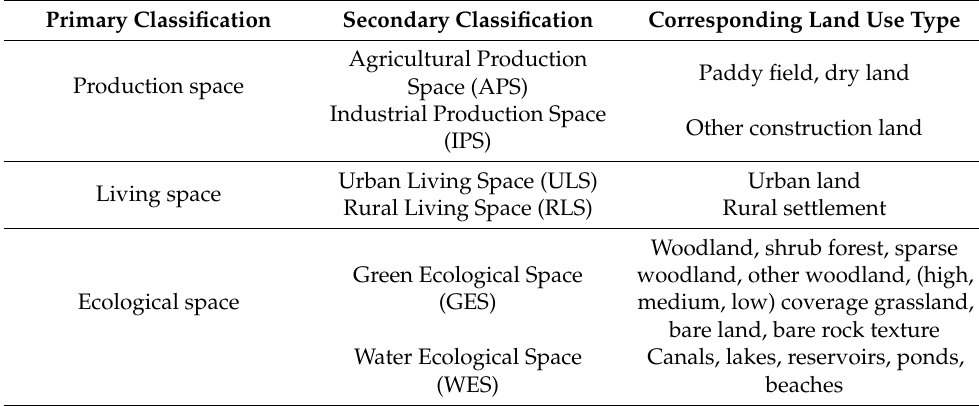
Table 2. The PLES classification method of the Chaohu Lake